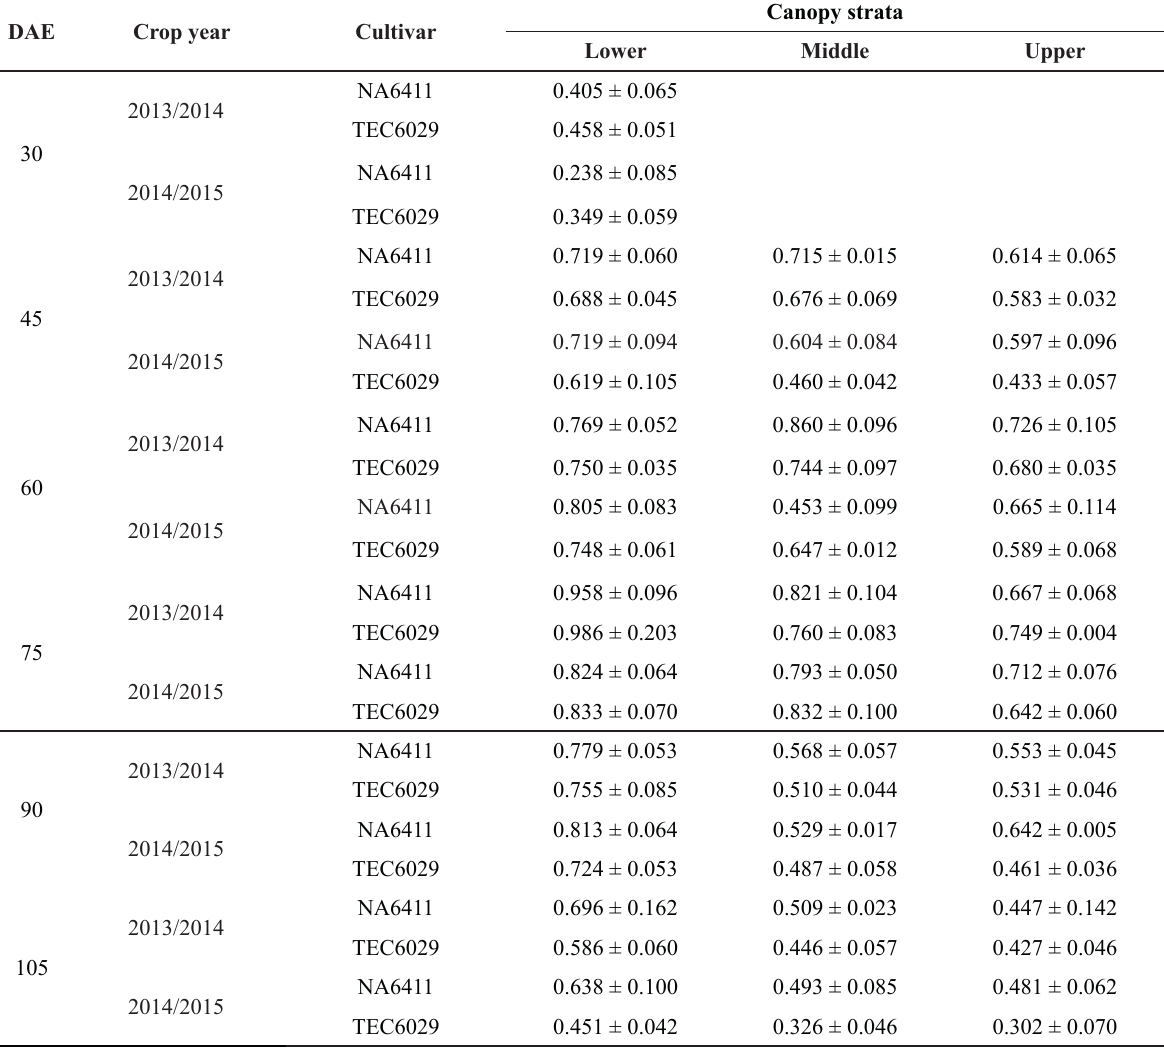
Light extinction coefficients (± standard error) in different canopy strata of the two soybean cultivars (NA6411 and TEC6029) in two crop years (2013/2014 and 2014/2015) at different evaluation periods in a field experiment in Frederico Westphalen,